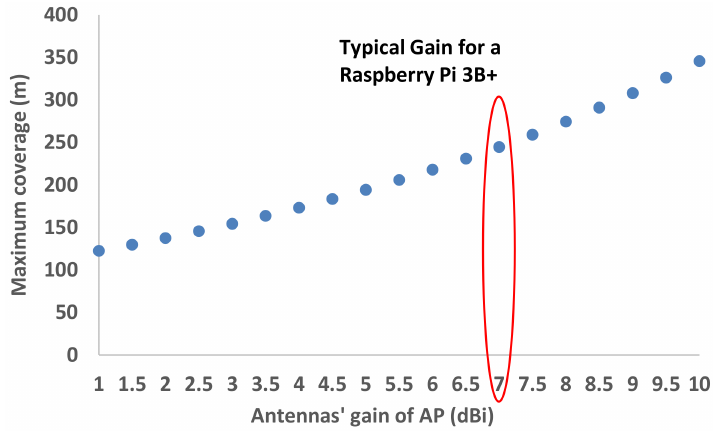
Figure 6. Ideal coverage for our system.